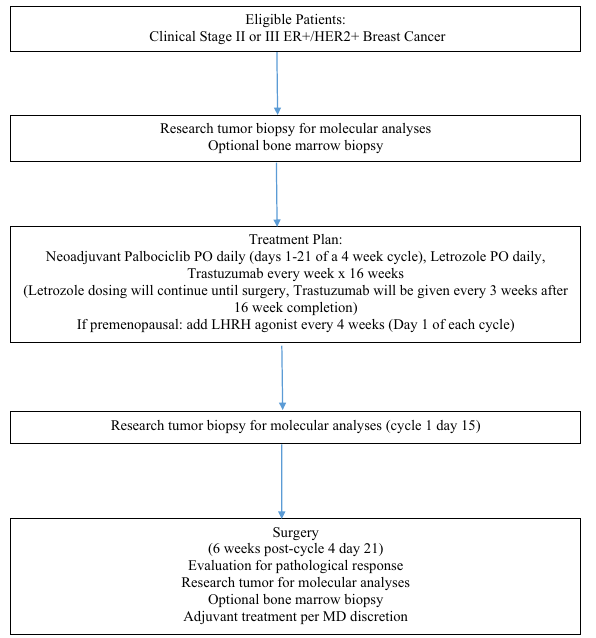
Fig. 7 Clinical trial schema. Diagram of a clinical trial showing chemotherapy regimen and biospecimen collection time